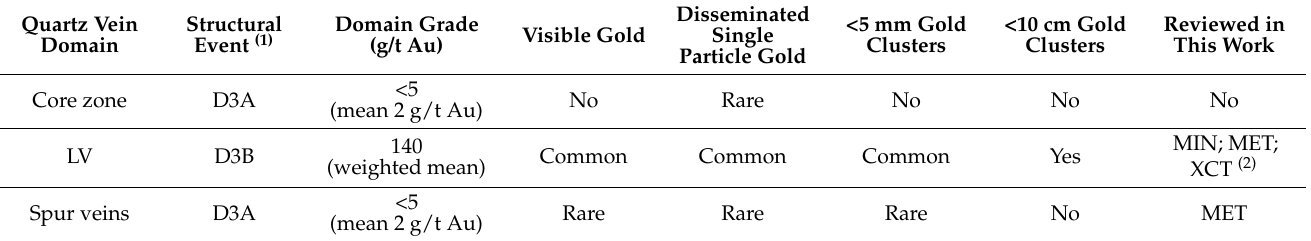
Table 2. Overview of quartz vein domains and the gold type identified in